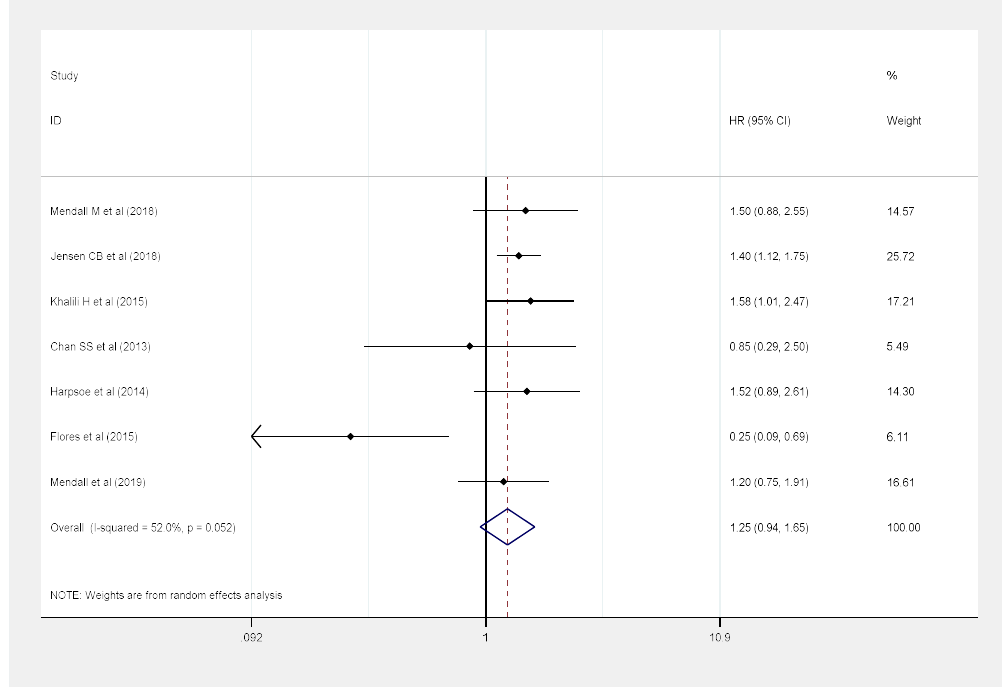
Figure 4. Association between obesity (BMI ≥30 kg/m 2 ) and risk of Crohn’s disease.